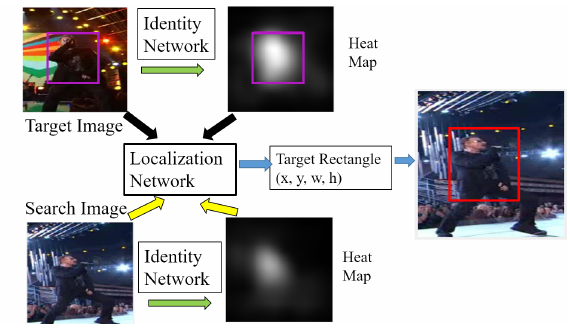
Figure 1. The tracking flow of proposition. In the proposed tracking framework, there are two different networks: one is for target location